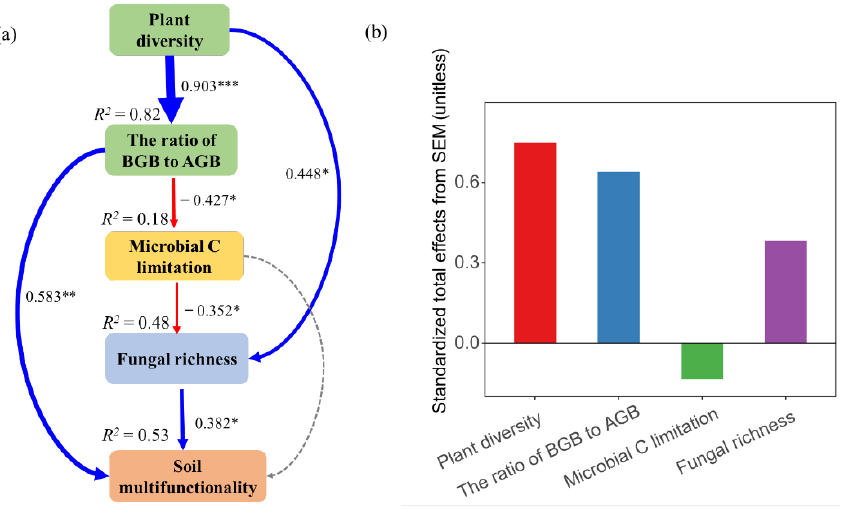
Figure 8. The piecewise structural equation model was used to test the direct and indirect relationships between plant diversity and soil multifunctionality ( a ). The corresponding values of the solid line arrows are the width of normalized path system arrows that reflect the size of the normalized path coefficient. The blue and red arrows show significant positive and negative correlations, respectively (* p < 0.05, ** p < 0.01, and *** p < 0.001). Dashed lines show non-significant relationships. The values above each variable represent the explanatory degree ( R 2 ) of each variable in the model. Standardized total effects (direct plus indirect effects) derived from the piecewise structural equation model ( b ).